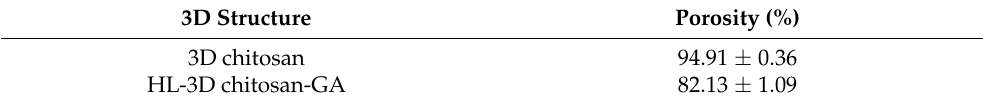
Table 3. Results from porosity measurements of 3D chitosan before and after GA adsorption.